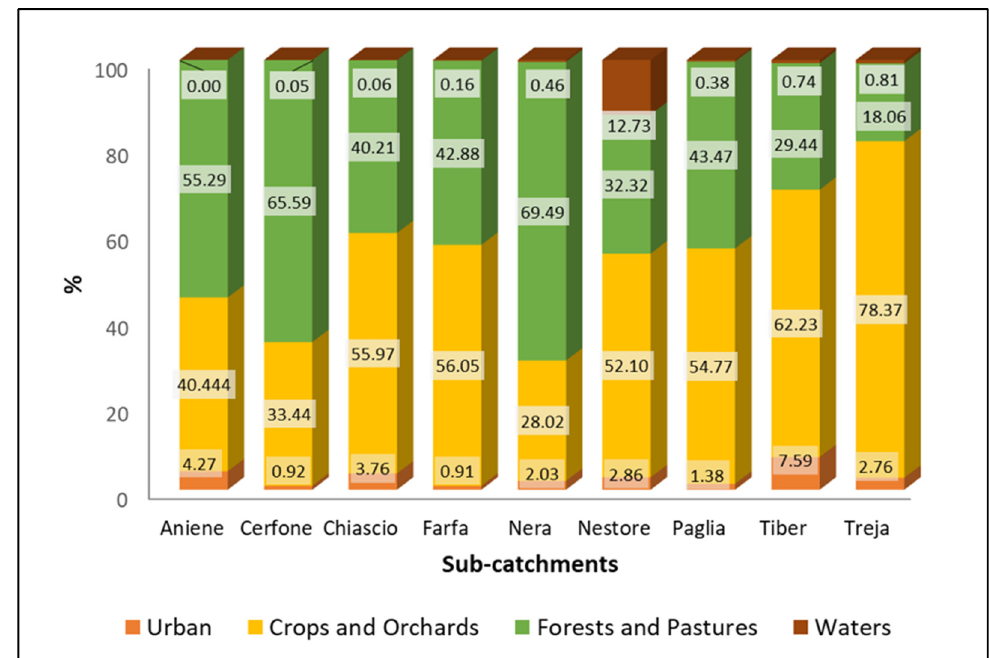
Figure 4. Repartition of the land-use categories among the sub-catchments .